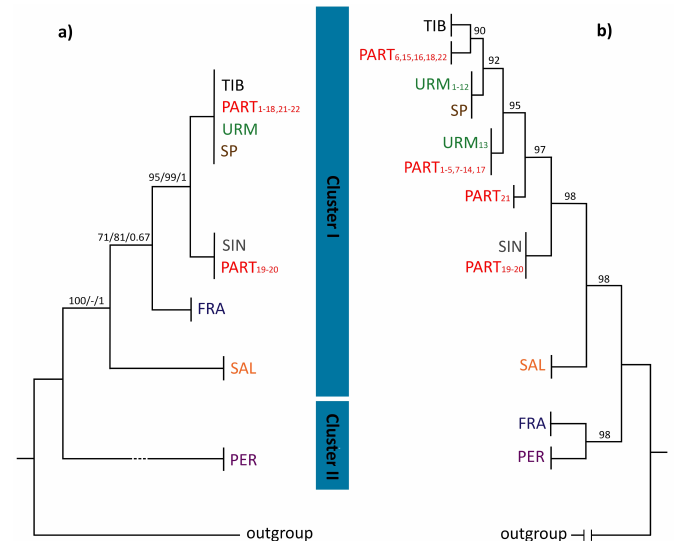
Fig. 4. Simplified phylogenetic trees of the genus Artemia based on 313 ITS1 sequences. Streptocephalus proboscideus was used as an out-group. a ) ML/BI/NJ trees inferred from primary sequence. Numbers on the nodes are: the bootstrap value from maximum-likelihood / that of neighbor-joining / the Bayesian posterior probability values. b ) PNJ tree based on sequence-structure. Numbers at the nodes represent the bootstrap values from profile neighbor-joining. (Abbreviations of species/population are defined in Table